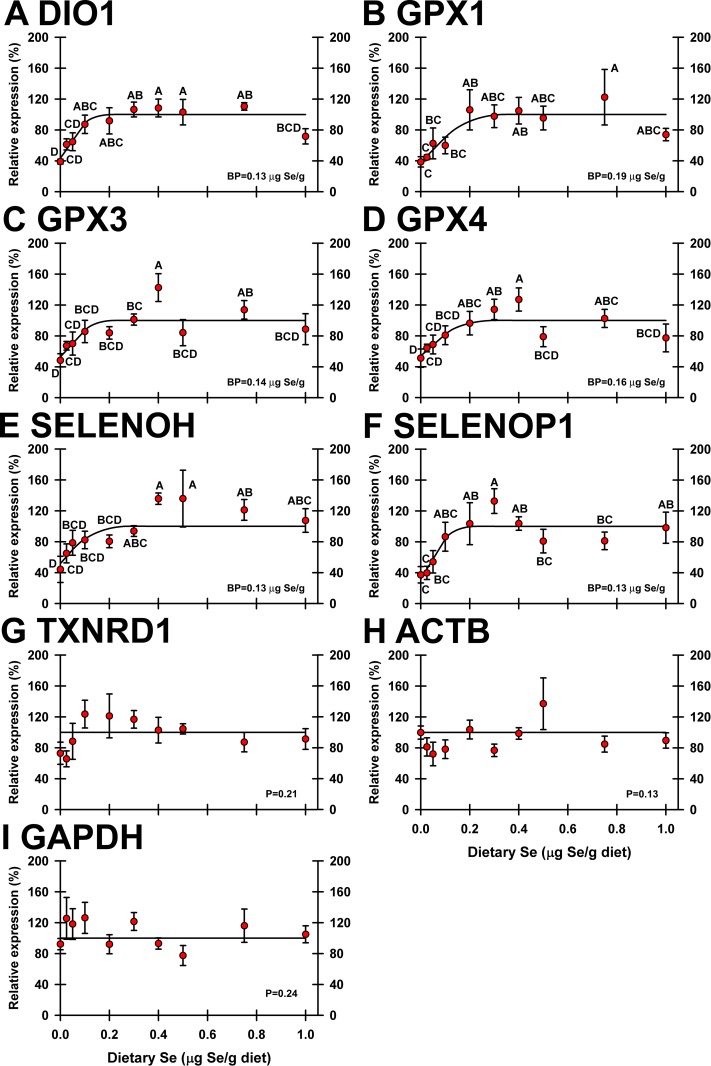
Effect of dietary Se on significantly-regulated selenoprotein transcripts in turkey kidney.Plotted are relative transcript levels for DIO1 (A), GPX1 (B), GPX3 (C), GPX4 (D), SELENOH (E), and SELENOP1 (F) in poults supplemented with graded levels of dietary Se for 28 d. Values shown are means ± SEM (n = 5/treatment). Means without a common letter are significantly different (p<0.05). Overall levels of significance, as determined by ANOVA, are given in Table 1. Se response curve breakpoints (BP) are calculated as described in text. Panels G and I show examples of transcripts (ACTB, GAPDH) not significantly regulated by dietary Se.